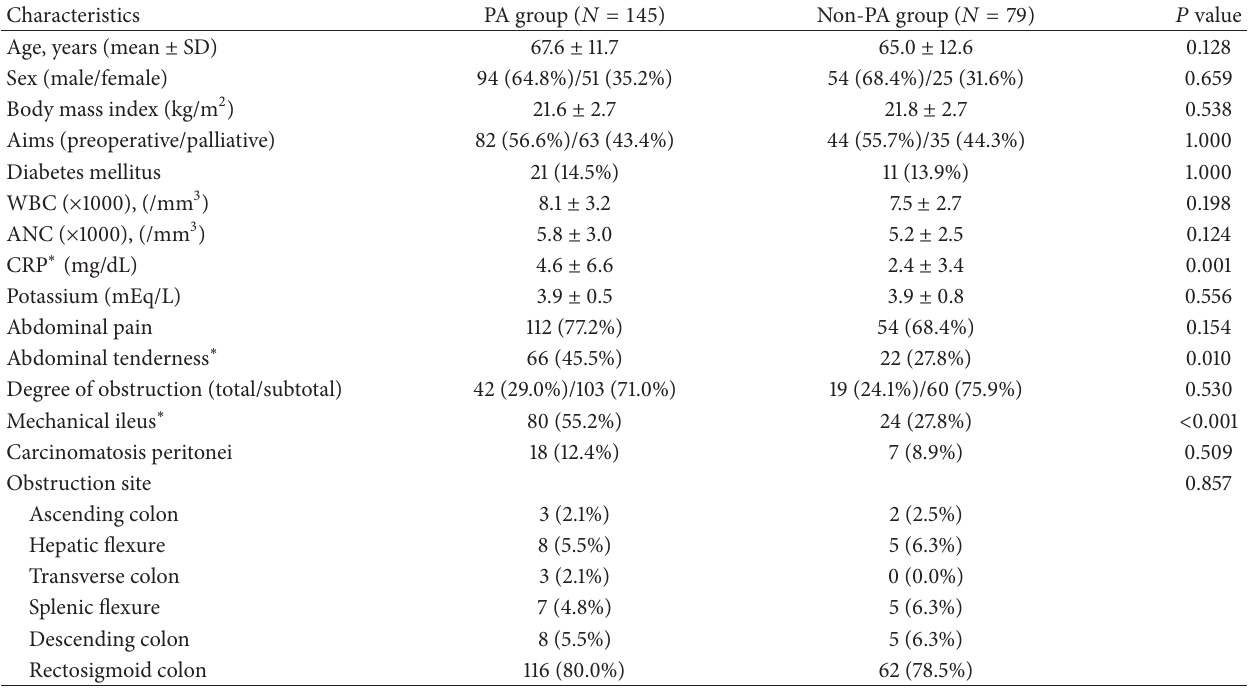
Table 1: Comparison of clinical characteristics in PA versus non-PA groups.